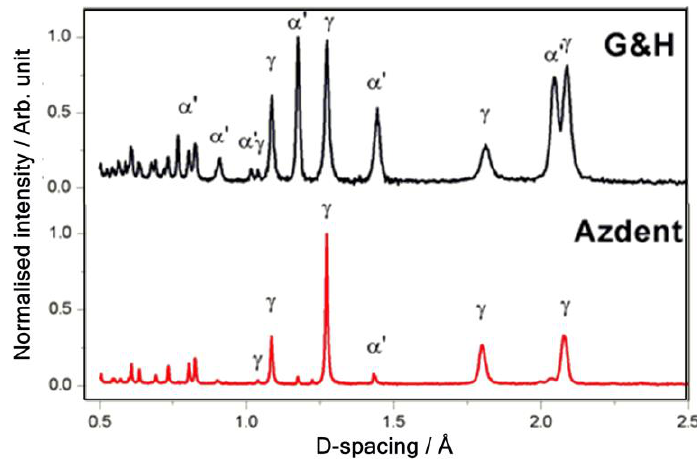
Figure 4. Di ff raction patterns of G&H ( upper ) and Azdent ( lower ), with the main γ austenite and α ’ martensite di ff raction peaks